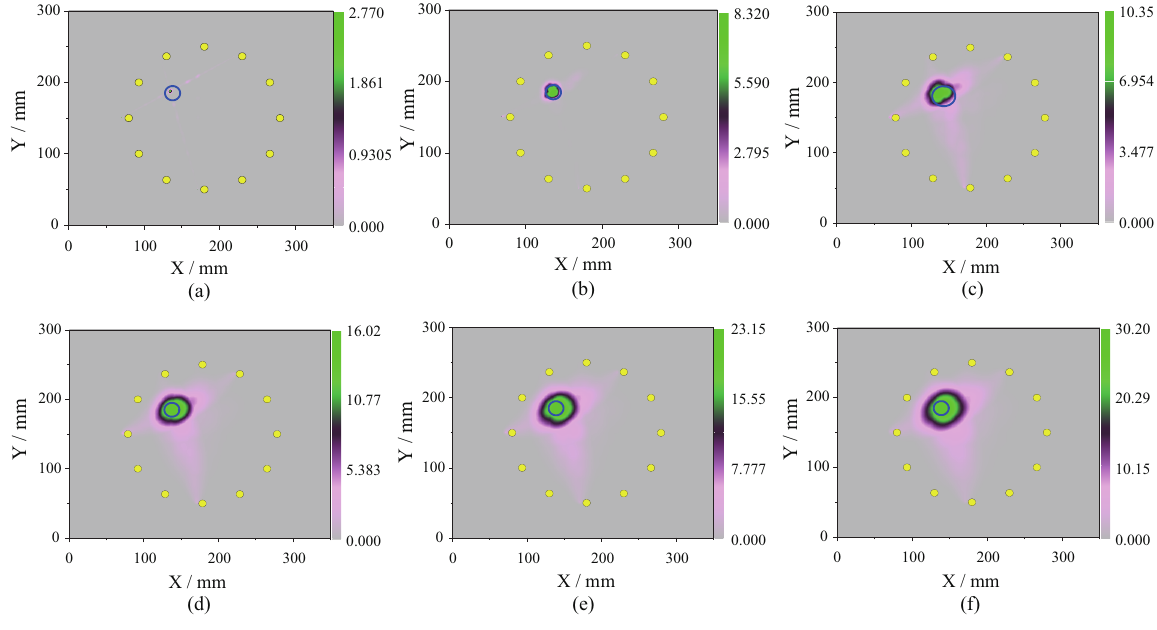
Fig. 11. Damage index in different paths of the stiffened composite panel.